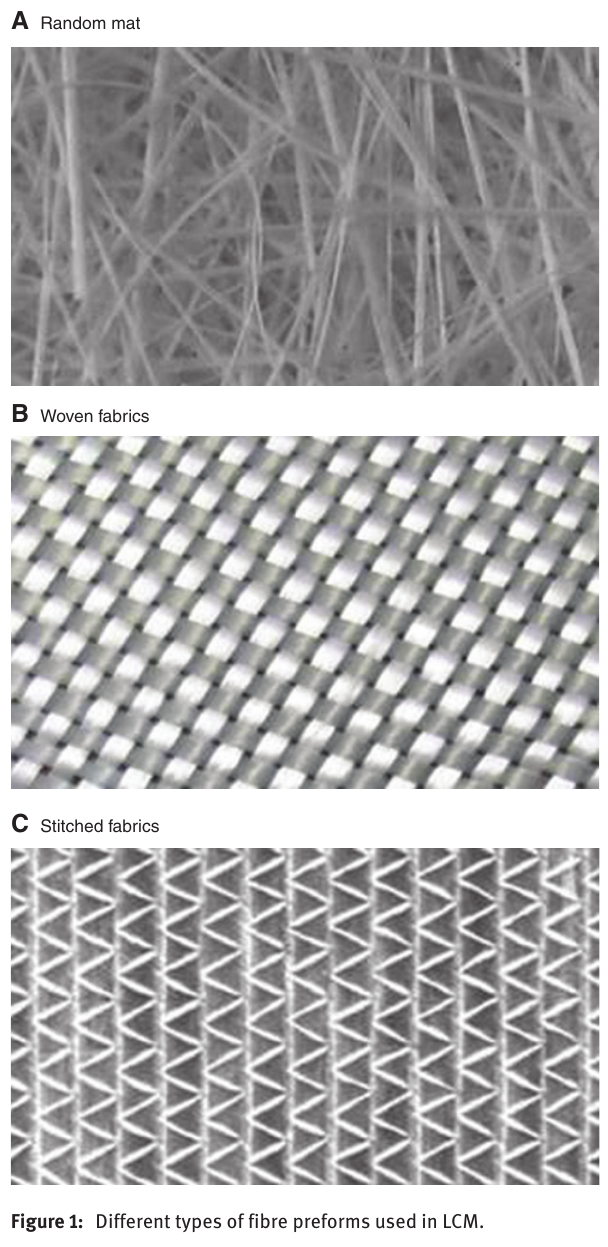
Figure 1: Different types of fibre preforms used in